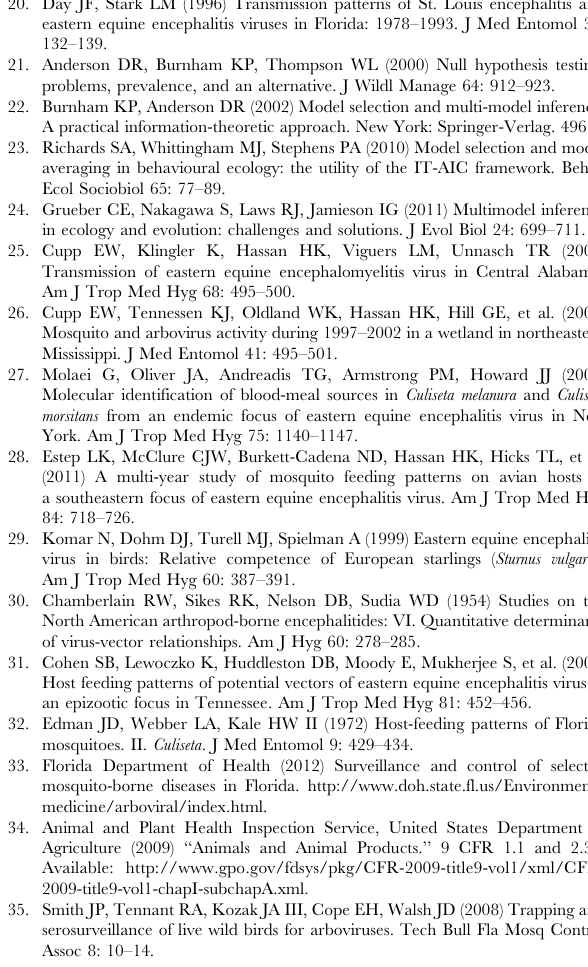
Table S3 Occupancy matrix for avian species detected during avian surveys in June 2010 at sentinel chicken flock site locations in Walton County,